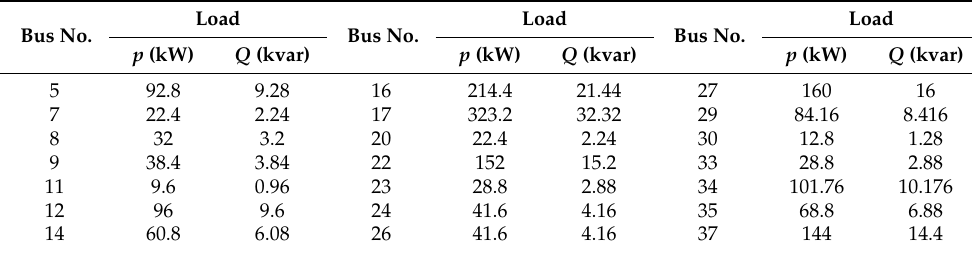
Table 2. Load demands of the stand-alone